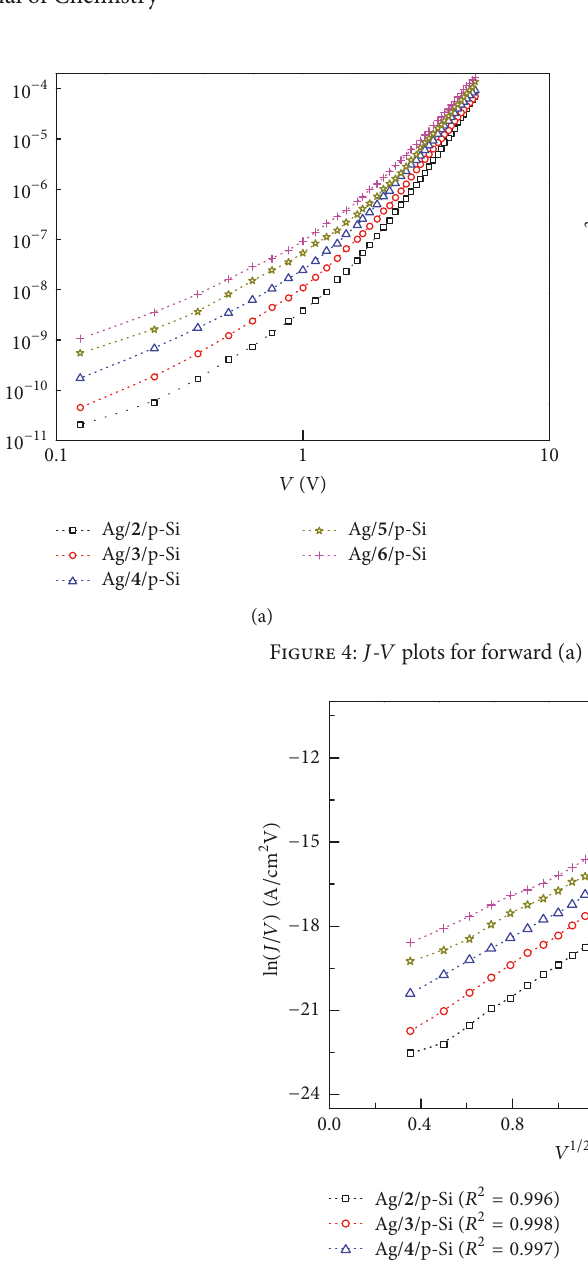
Figure 5: Poole-Frenkel plots for the device investigated under forward bias